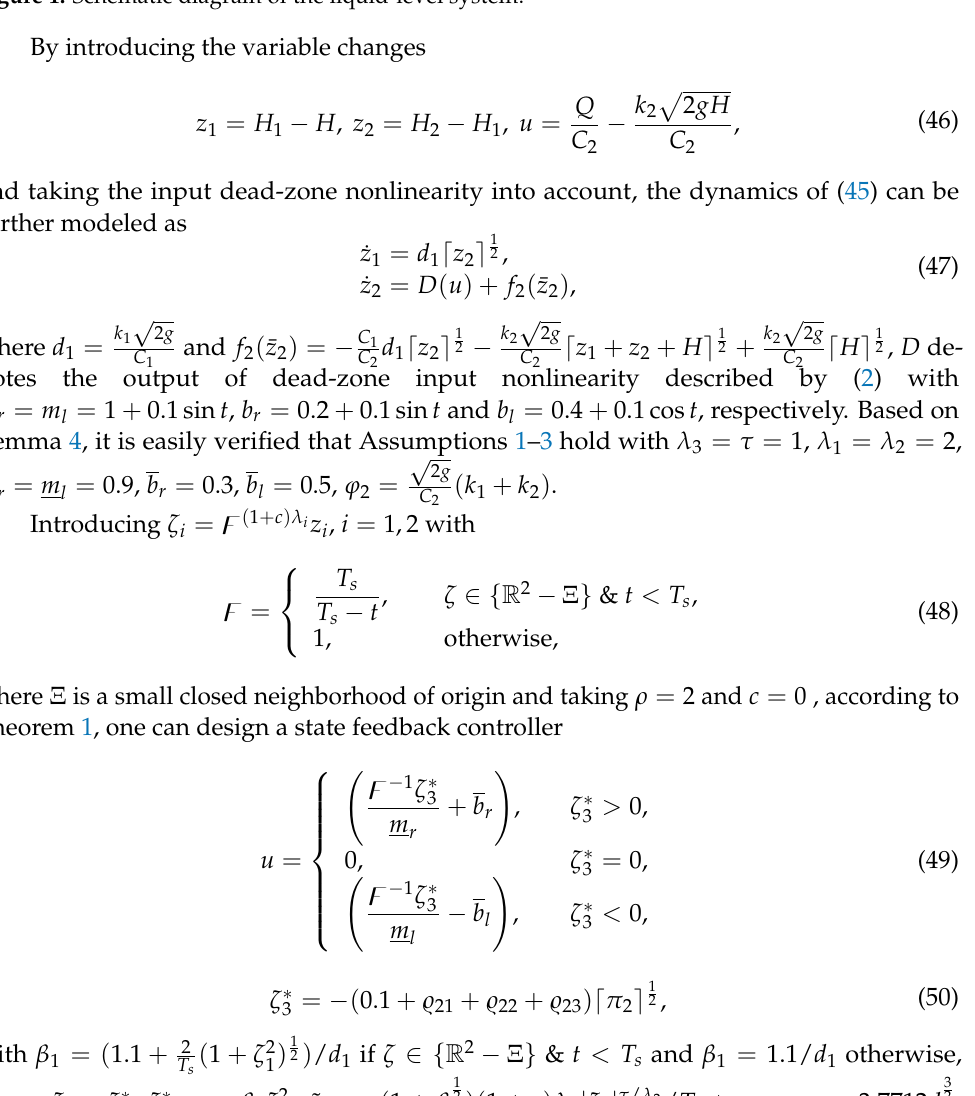
Figure 1. Schematic diagram of the liquid-level